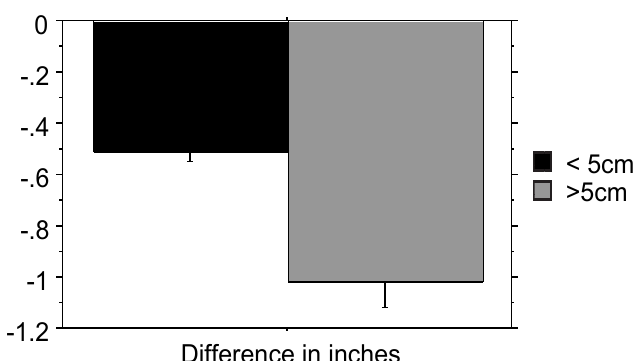
Figure 4. Physicians’ overestimation in inches based on actual wound